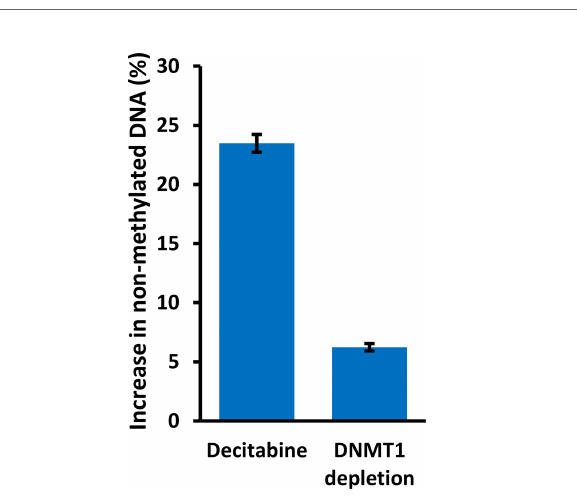
FIGURE 8 | DNMT1 reduces methylation at the TAp63 promoter but with a lesser effect than decitabine. Parental HaCaT and FaDu cells were treated with 10 µM decitabine for four days, or DNMT1 -shRNA cells were induced with 2 µg/ml doxycycline for six days. DNA was bisul fi te converted and PCR products were sequenced to analyze the extent of CpG methylation at site A. The plot shows the percentage increase in non-methylated cytosine (average changes in HaCaT and FaDu combined) after treatment, compared to matched control cells without decitabine or